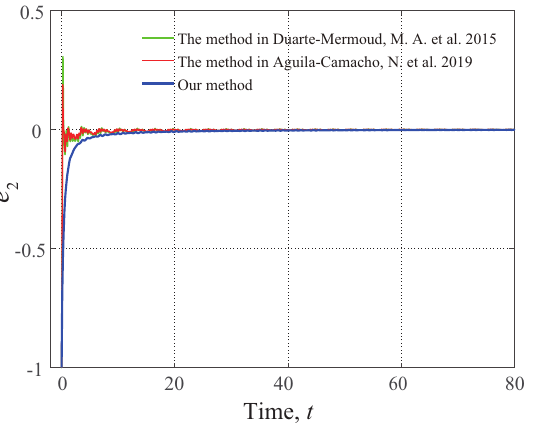
Figure 10. Time evolution of tracking error e 2 ( t ) with the standard fractional order adaptive con- troller in Duarte-Mermoud, M. A. et al. [23], the fractional adaptive controller in Aguila-Camacho, N. et al. [24], and our proposed adaptive controller with the fractional-order scalar update law in this